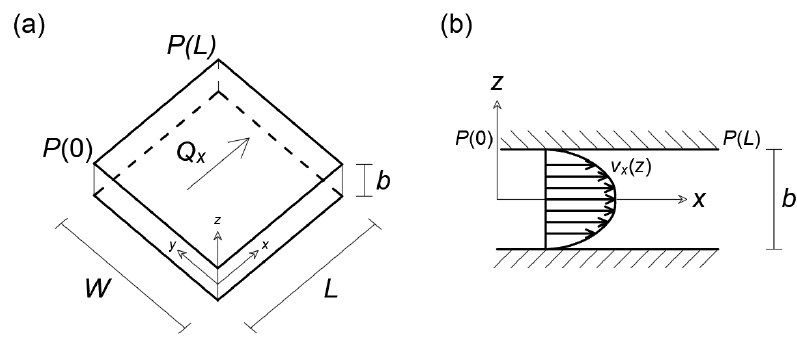
Figure 1. Parallel-plate model: (a) model representation and (b) cross-sectional velocity profile.